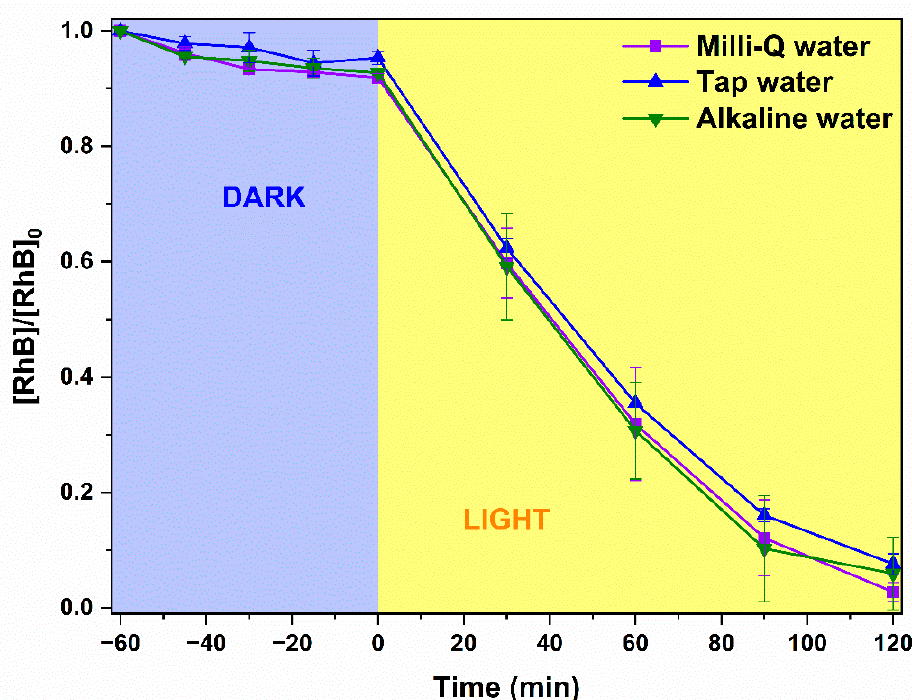
Figure 8. Effect of different water matrices (Milli-Q water, tap water, and alkaline water (Fructal)) on the degradation efficiency of RhB dye using rGO/TiO 2 /CN nanocomposite photocatalyst under solar-like irradiation. Table 4. The values of the first-order rate constant ( k ) and efficiency ( η ) of RhB dye photodegradation by rGO/TiO 2 /CN nanocomposite photocatalyst, in different water